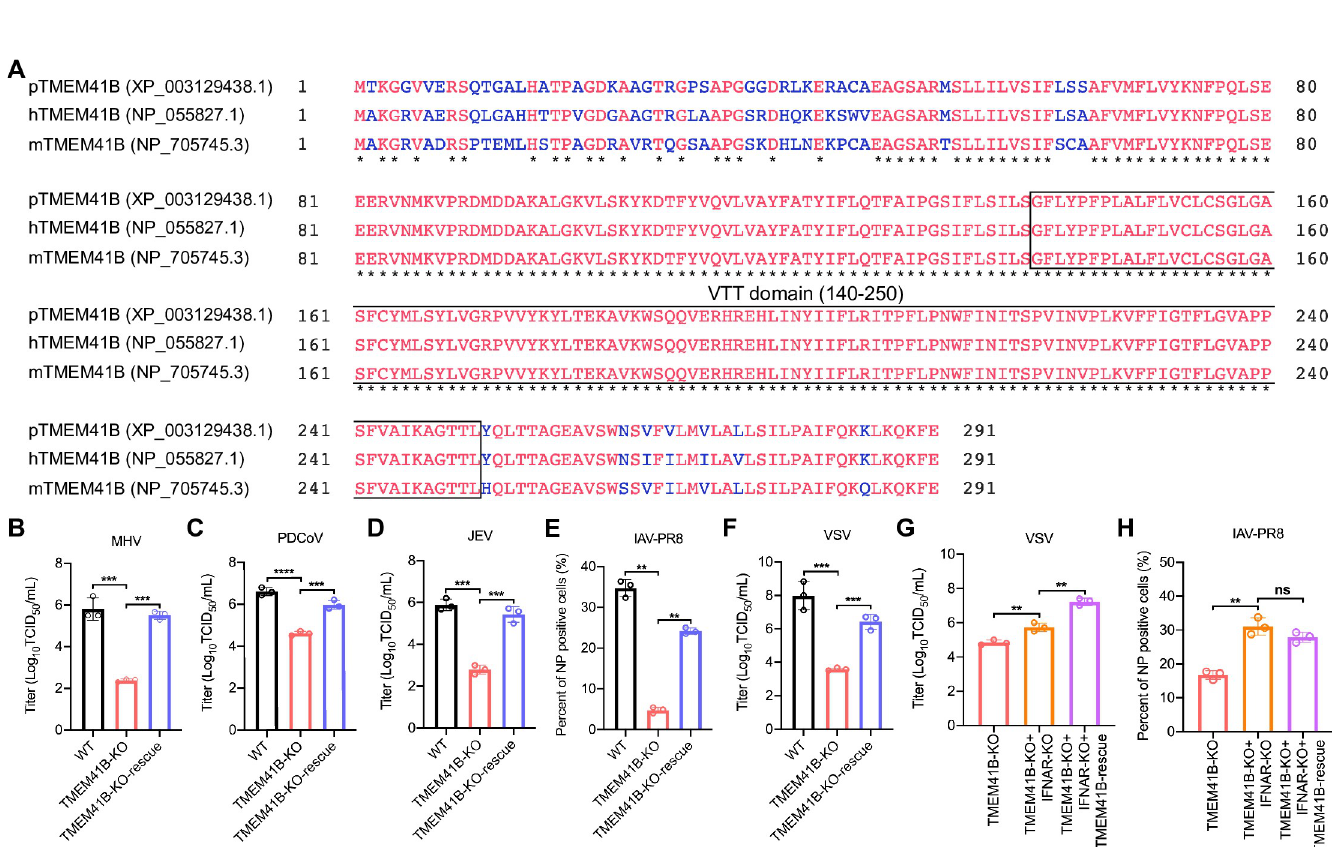
Fig 6. TMEM41B is a host factor for the replication of multiple viruses. (A) Alignment of TMEM41B amino acid sequences from pigs, human and mice. The accession Numbers of TMEM41B from NCBI protein database for Sus scrofa is XP_003129438.1 (pTMEM41B), for Homo sapiens is NP_055827.1 (hTMEM41B), and for Mus musculus is NP_705745.3 (mTMEM41B). Protein sequences were aligned using Constraint-based Multiple Alignment Tool (COBALT). The dark star indicates the regions of sequence conservation amongst the three species (letters indicated in red); the blue letters indicate the regions with sequence variation among the three species; the box indicates the VTT domain. (B) Rescue assays for WT, TMEM41B-KO and TMEM41B-KO-rescue L929 cells infected with MHV (MOI = 0.1, 24 hpi). Cell supernatant was collected and assessed for MHV titers using TCID 50 . (C-F) Rescue assays for WT, TMEM41B-KO and TMEM41B-KO-rescue PK-15 cells infected with (C) PDCoV (MOI = 0.01, 18 hpi), (D) JEV (MOI = 0.1, 24hpi), (E) IAV-PR8 (MOI = 0.01, 24 hpi) and (F) VSV (MOI = 0.01, 18 hpi). The cell supernatant was collected and tittered using TCID 50 assays and immunofluorescence assays to detect NP positive cells. (G) Viral titers for TMEM41B-KO, TMEM41B/IFNAR double KO and TMEM41B/IFNAR double KO-TMEM41B-rescue cells infected with VSV (MOI = 0.1, 18 hpi) and cell supernatants was collected and titrated using TCID 50 . (H) Immunofluorescence assays for TMEM41B-KO, TMEM41B/IFNAR double KO and TMEM41B/IFNAR double KO-TMEM41B-rescue cells infected with IAV (MOI = 0.1, 18 hpi) and detection the NP positive cells. WT, wild-type; KO, knockout; hpi, hours post-infection; MHV, Mouse hepatitis virus; PDCoV, porcine deltacoronavirus; JEV, Japanese encephalitis virus; IAV-PR8, PR8 influenza A virus; VSV, Vesicular stomatitis virus. �� P < 0.01; ��� P < 0.001; ���� P < 0.0001. P values were determined by two-sided Student’s t-test. Data are representative of at least three independent experiments.